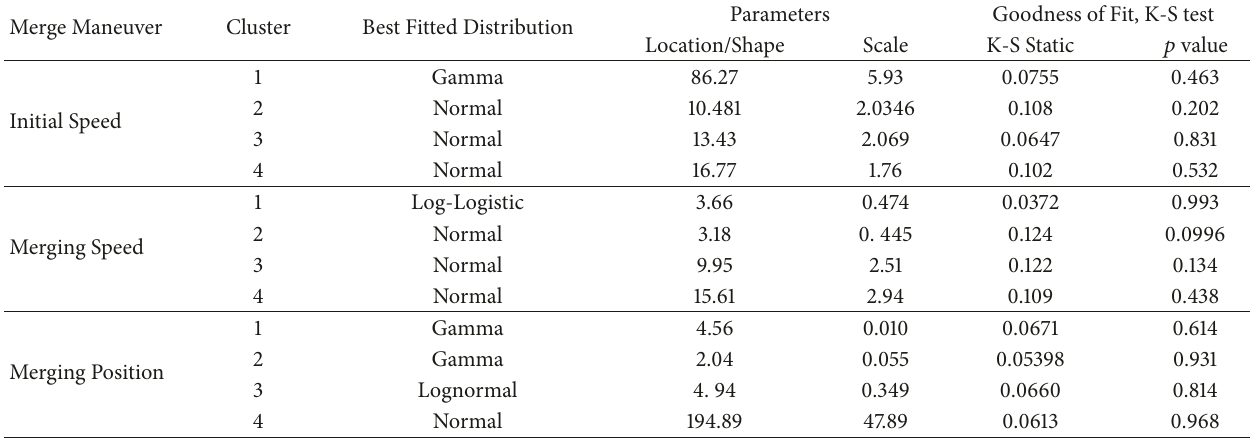
Table 3: Distribution fitting results of merging maneuver parameters for different